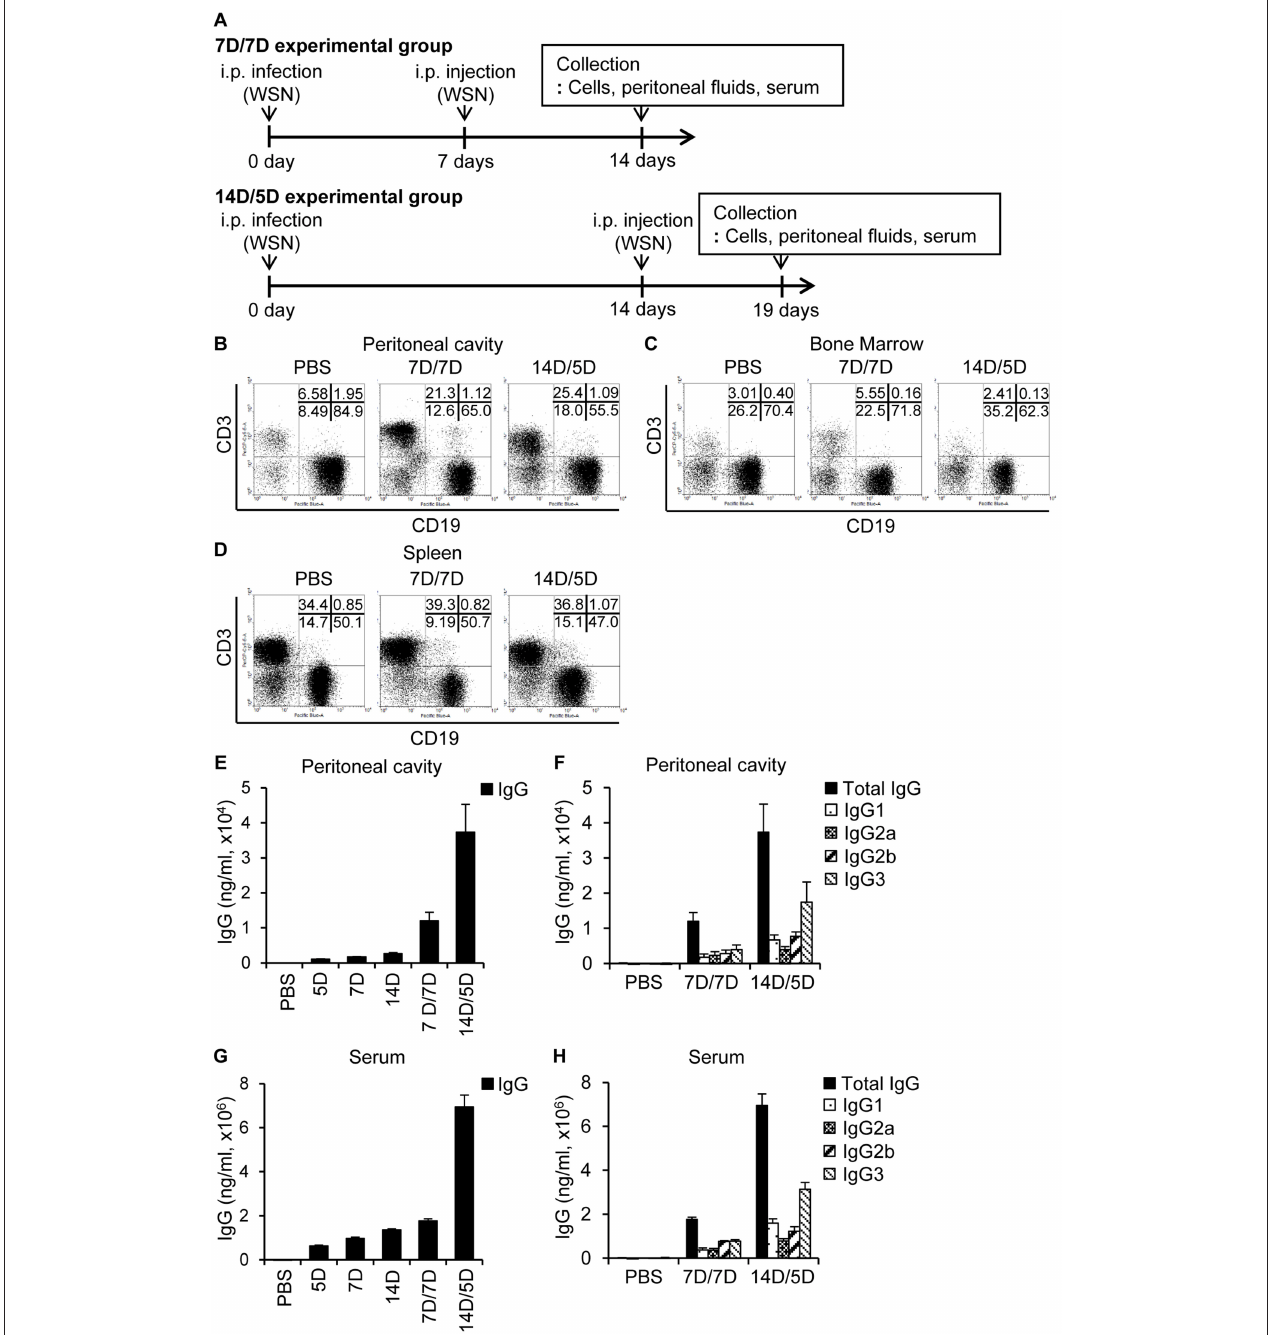
FIGURE 5 | Re-infection with A/WSN/1933 virus limits B cell death and induces antibody production. (A) Schematic diagram of the experimental procedure. BALB/c mice ( n = 5/group) were sacrificed after repeated intraperitoneal inoculation with PBS or 5 × 10 6 pfu of A/WSN/1933 virus. 7D/7D represents a procedure consisting of a first infection, a second infection after 7 days, and then sacrifice after another 7 days. 14D/5D represents a procedure of first infection, second infection after 14 days, and then sacrifice after another 5 days. Peritoneal cavity cells (B) , bone marrow cells (C) , and splenocytes (D) (FSC low SSC low ) were gated, and stained with fluorescence-conjugated antibodies (CD19, B220) and then analyzed by flow cytometry. (E–H) Peritoneal cavity fluids and sera were collected from the mice and the amounts of total IgG (E,G) and IgG subclasses (F,H) in the peritoneal cavity (E,F) and serum (G,H) were quantified by ELISA. Figures are representative of three replicate